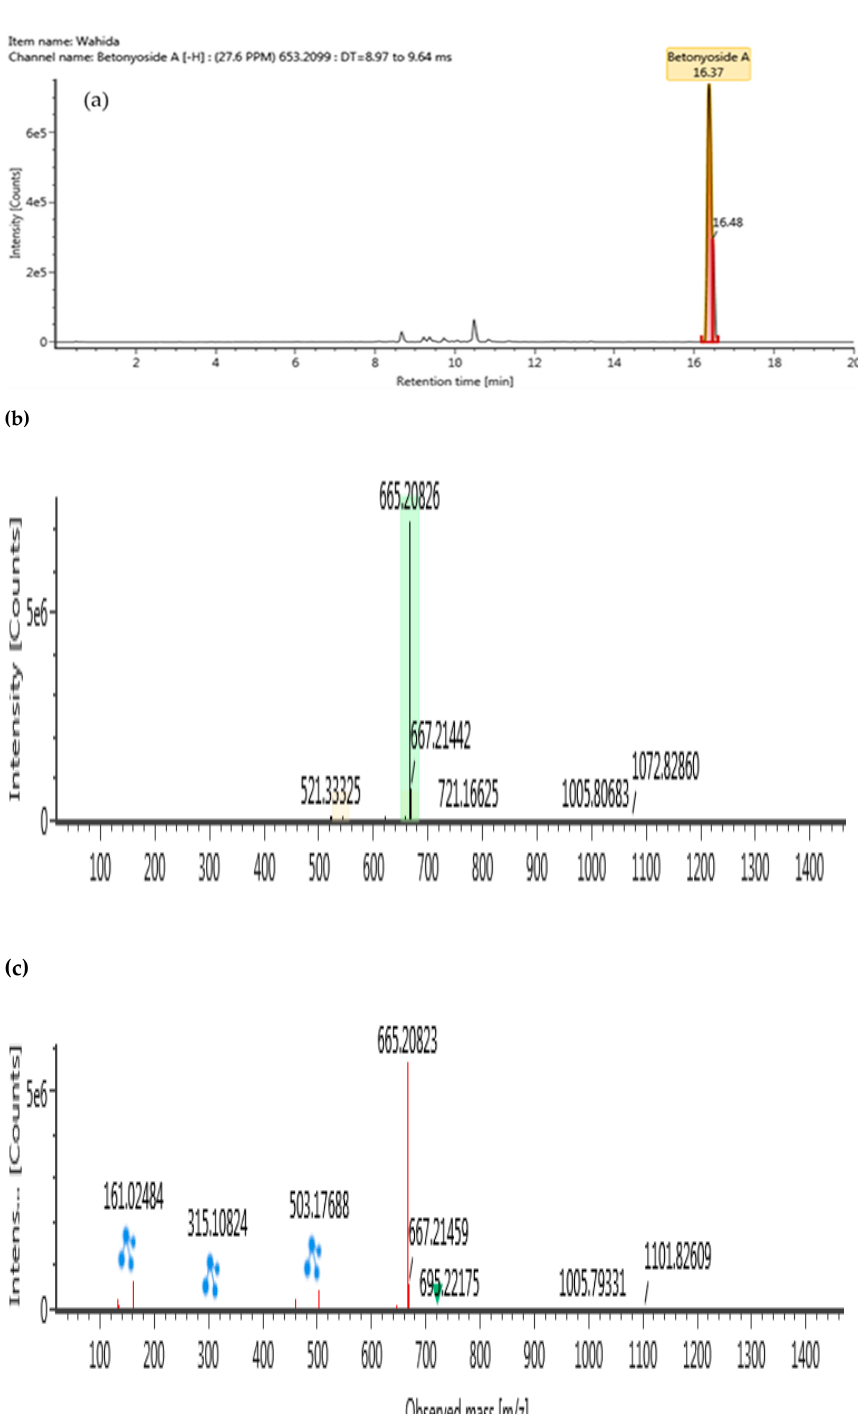
Figure 9. UHPLC ‐ QTOF/MS chromatograms of betonyoside A from Barleria lupulina Lindl. leaf Figure 9. UHPLC-QTOF/MS chromatograms of betonyoside A from Barleria lupulina Lindl. leaf extract (BLLE): ( a ) chro- extract (BLLE): ( a ) chromatogram mass spectrum; ( b ) low energy of mass spectrum; ( c ) high en ‐ matogram mass spectrum; ( b ) low energy of mass spectrum; ( c ) high energy of mass ergy of mass spectrum.